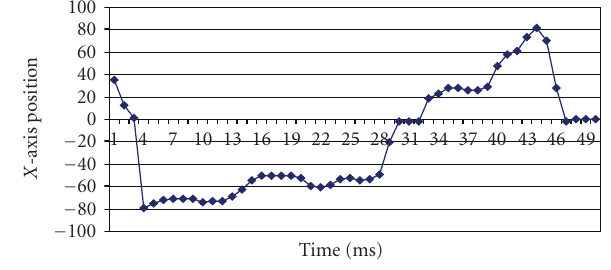
Figure 10: Data generated at server.